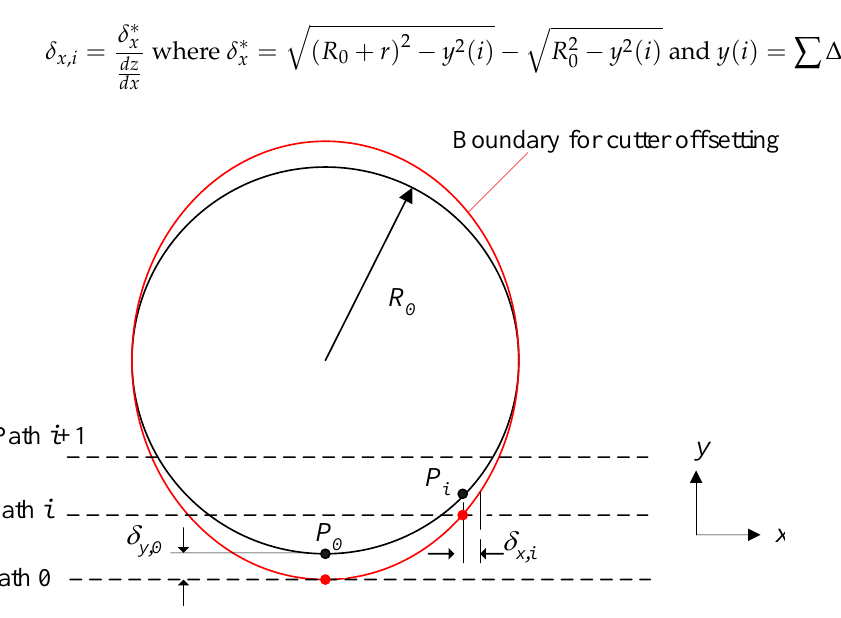
Figure 5. Geometry compensation of surface profile using cutter offsetting. Interference is not only happening in the profile of the curved surface ( x-z and y-z plane) but also in the boundary of the surface ( x-y plane). As shown in Figure 6, if the designed boundary of the curved surface is a circle with radius R 0 (black curve in the figure), the cutter path needs offsetting to compensate for the cutter interference. Therefore, the practical boundary must become the boundary with cutter offsetting (the red curve in this figure). As shown in Figure 6, the compensation of path direction ( x -direction) δ x,i is: